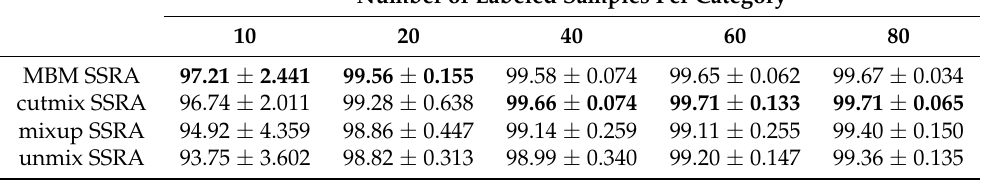
Table 3. Recognition accuracies of the proposed semi-supervised learning method, cutmix semi- supervised learning method, mixup semi-supervised learning method, and unmixed semi-supervised learning method under different amounts of labeled samples per category on the MSTAR data set. The bold numbers represent the optimal value in each